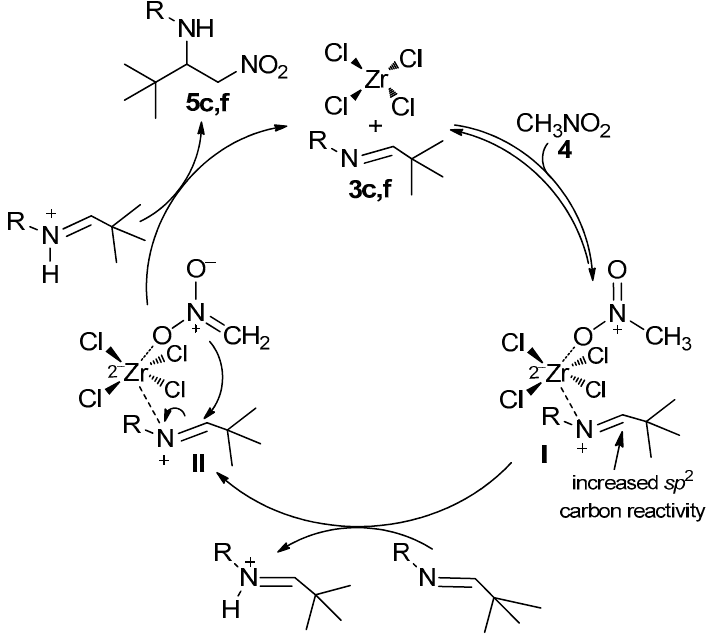
Figure 2. Proposed outcome for the ZrCl 4 -catalyzed addition. Figure 3. Proposed outcome for the ZrCl